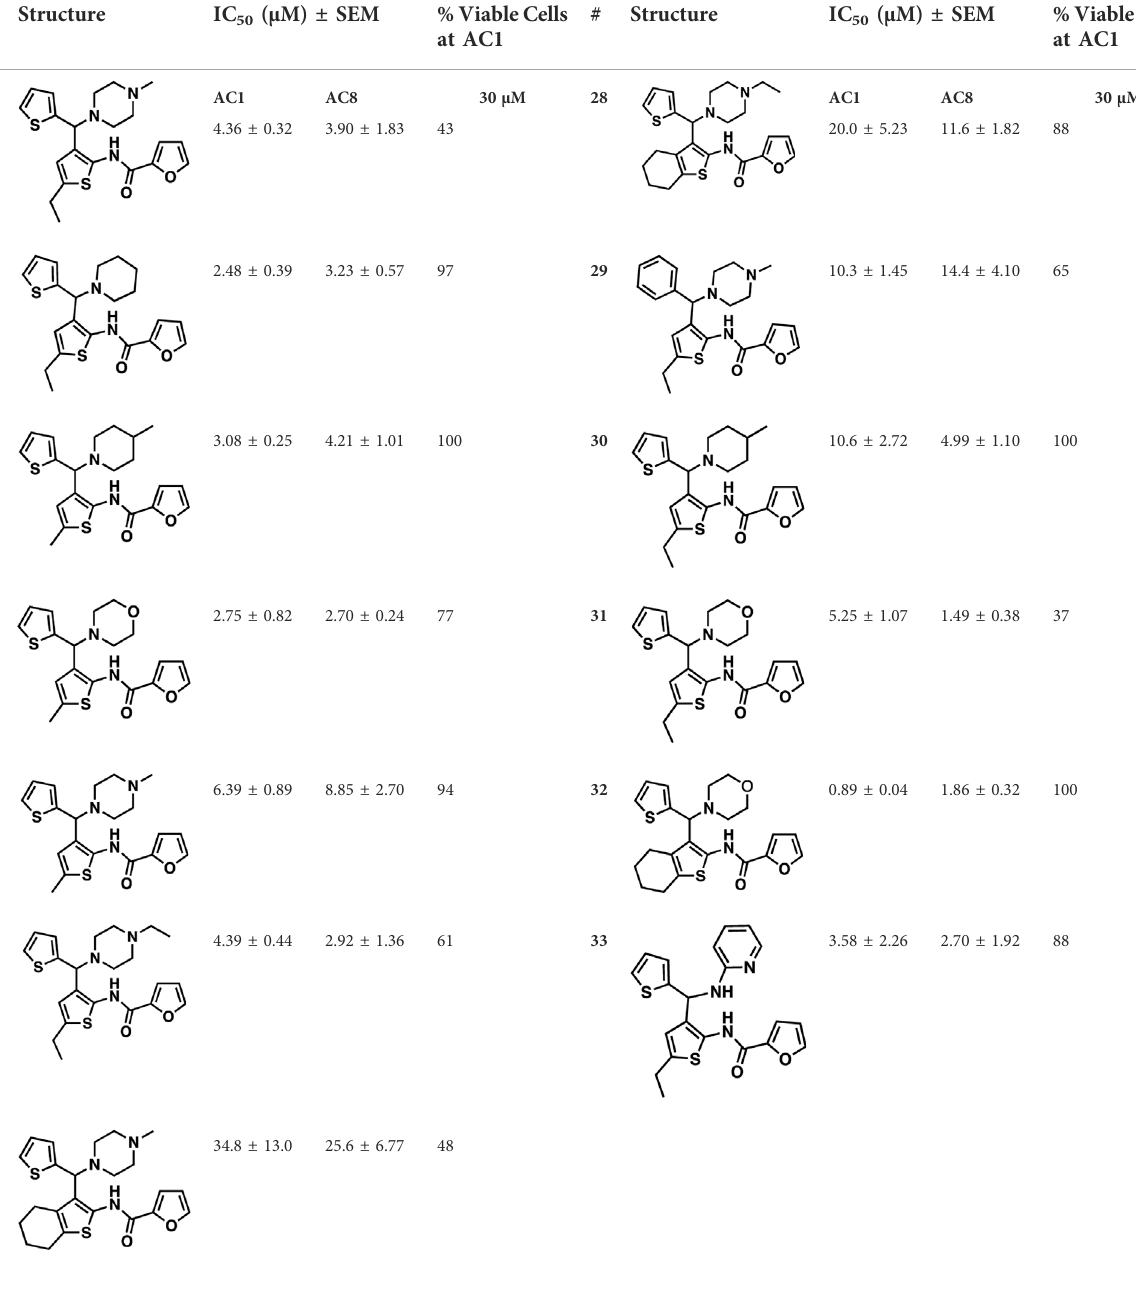
TABLE6CDIanalogstructures,IC 50 valuesfromcAMPaccumulationassaysinAC1-andAC8-HEK Δ 3/6KOcells,andcellviabilityinAC1-HEK Δ 3/6KO cells. IC 50 values were generated from a 3-parameter nonlinear regression of the averages of 3 independent experiments (N =